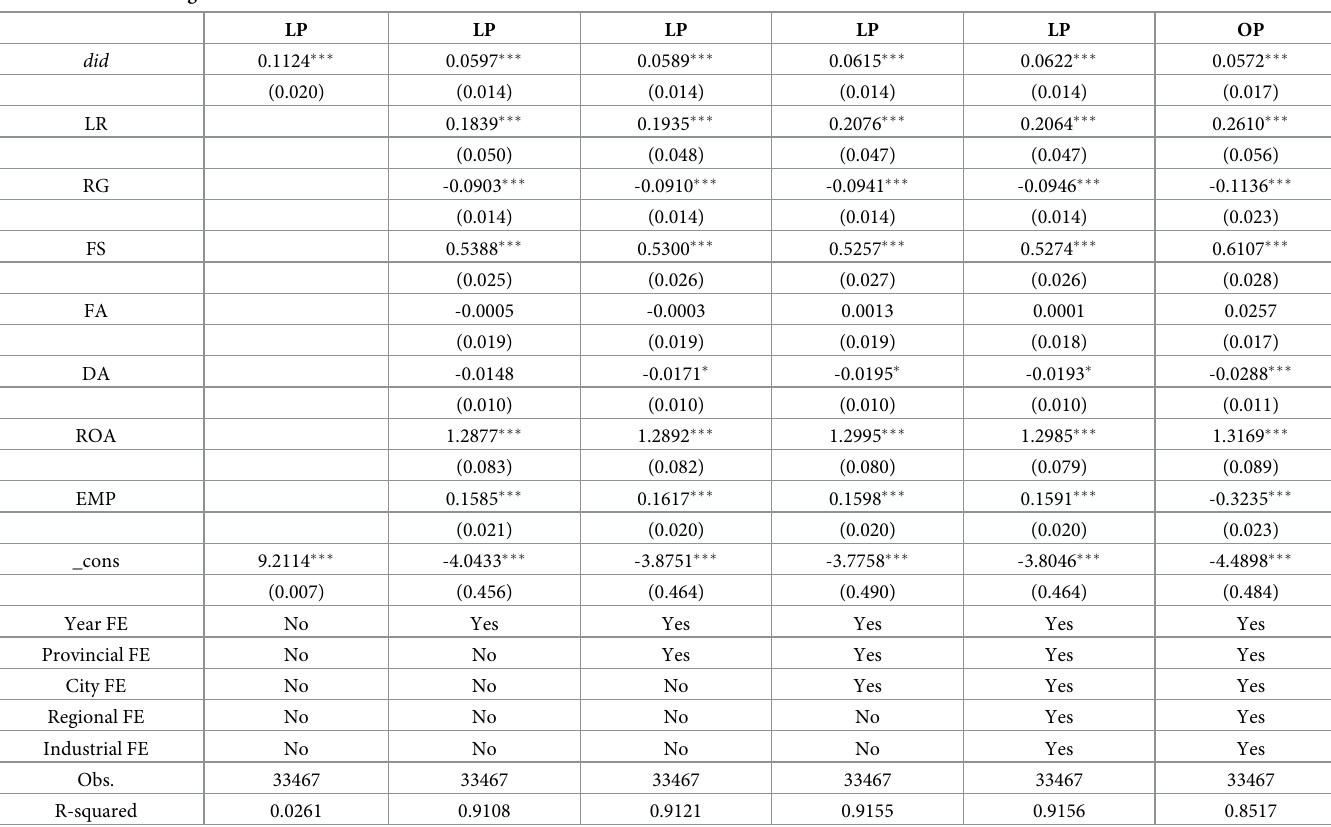
Table 3. Benchmark regression